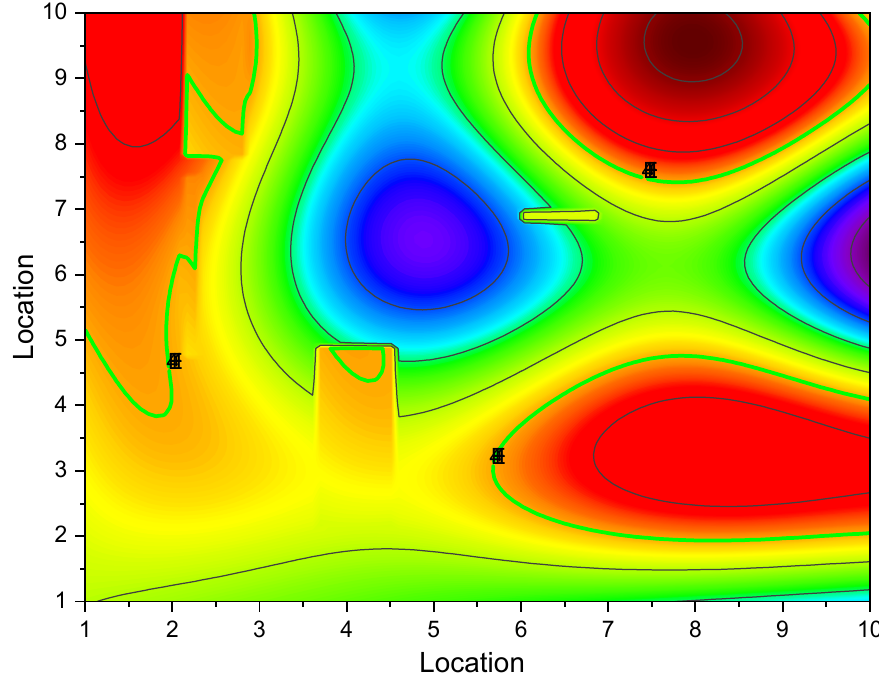
Figure 4. Example of visualization results.